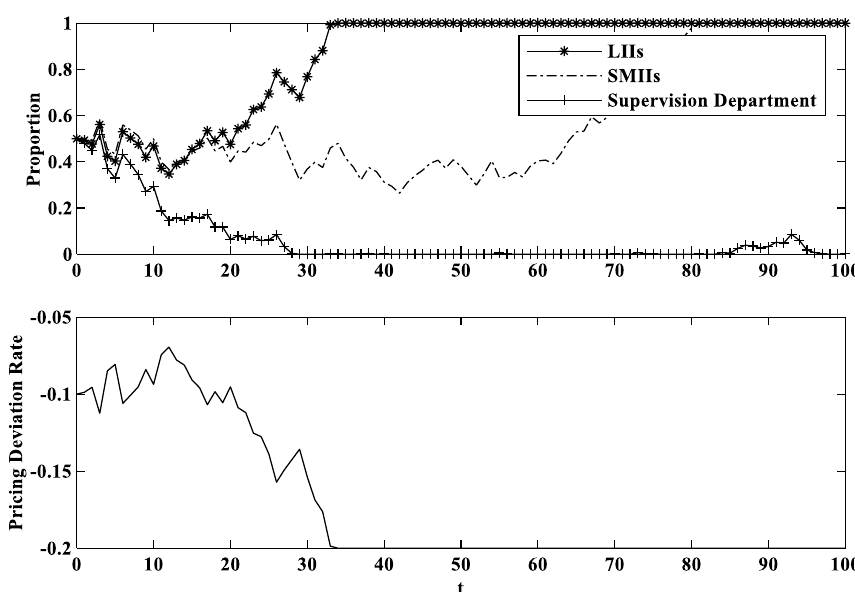
Fig. 10 Strategy evolution and market performance under scenario 2